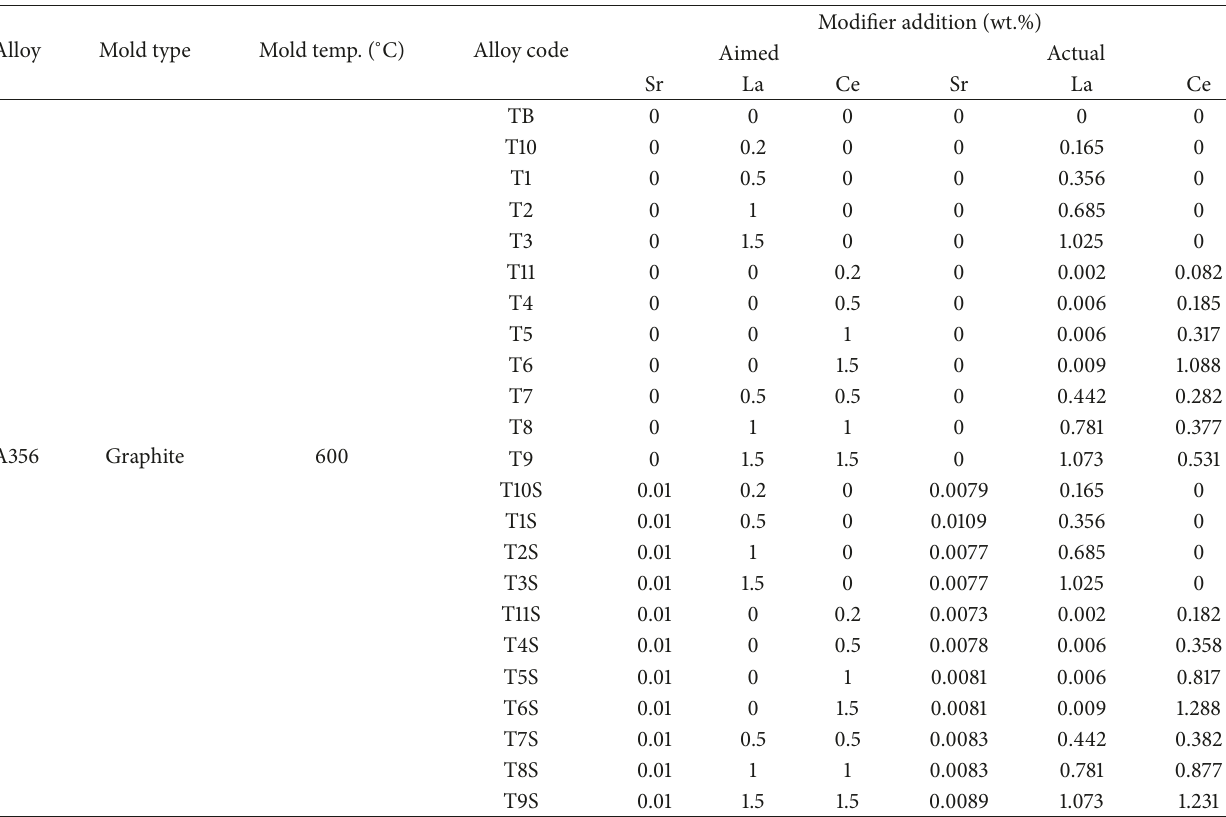
(a) Modifier additions and corresponding A356 alloy codes, graphite mold